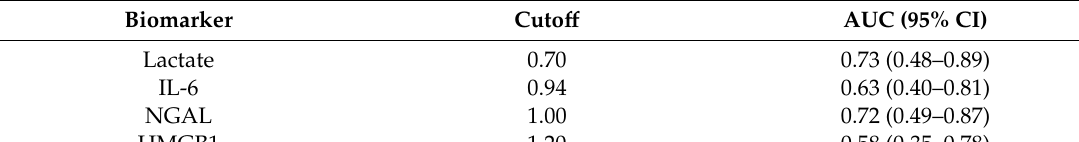
Table 2. The cuto ff and area under the curve (AUC) of each biomarker for ICU mortality.